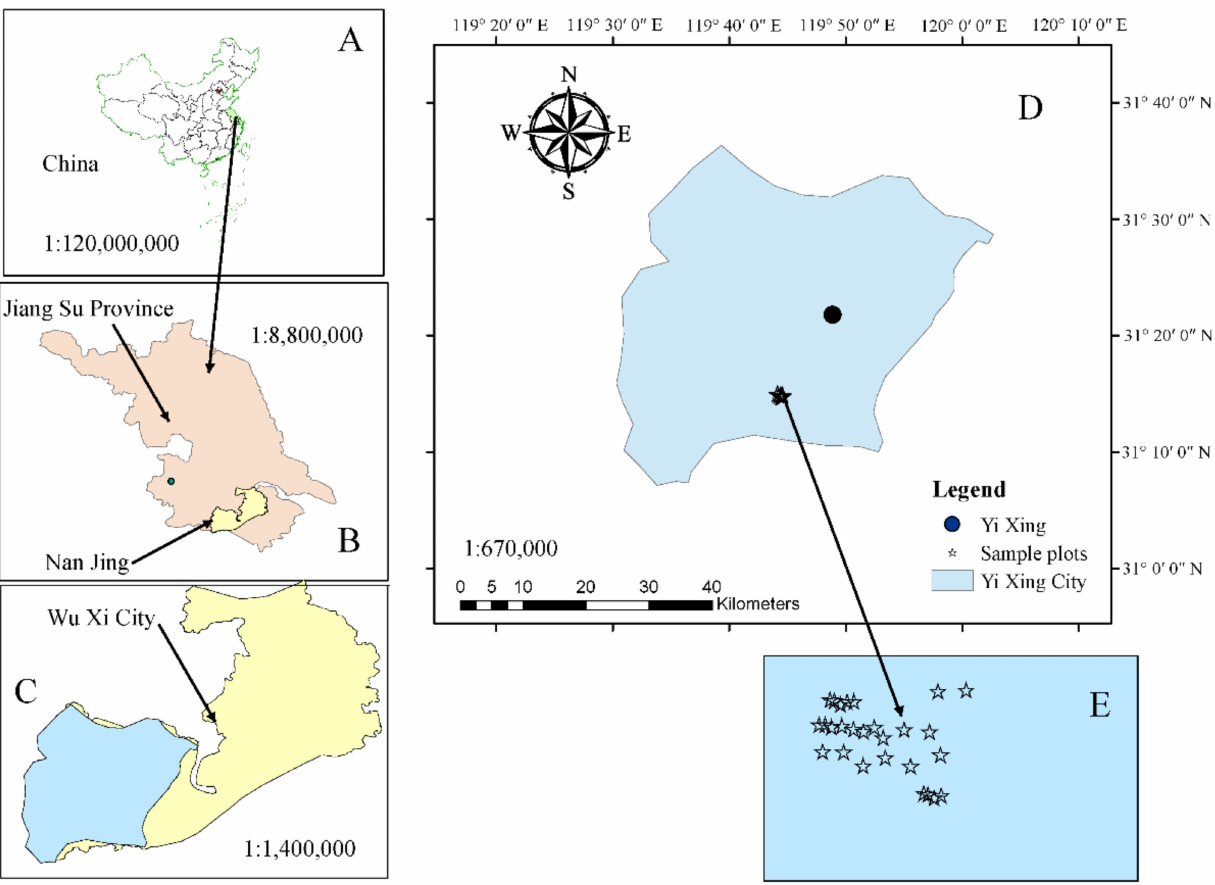
Figure 1. Study area showing location of sample plots. Note: ( A , B , C , D and E ) represents China, Jiangsu Province, Wuxi City, Yixing City, and sample plot locations,